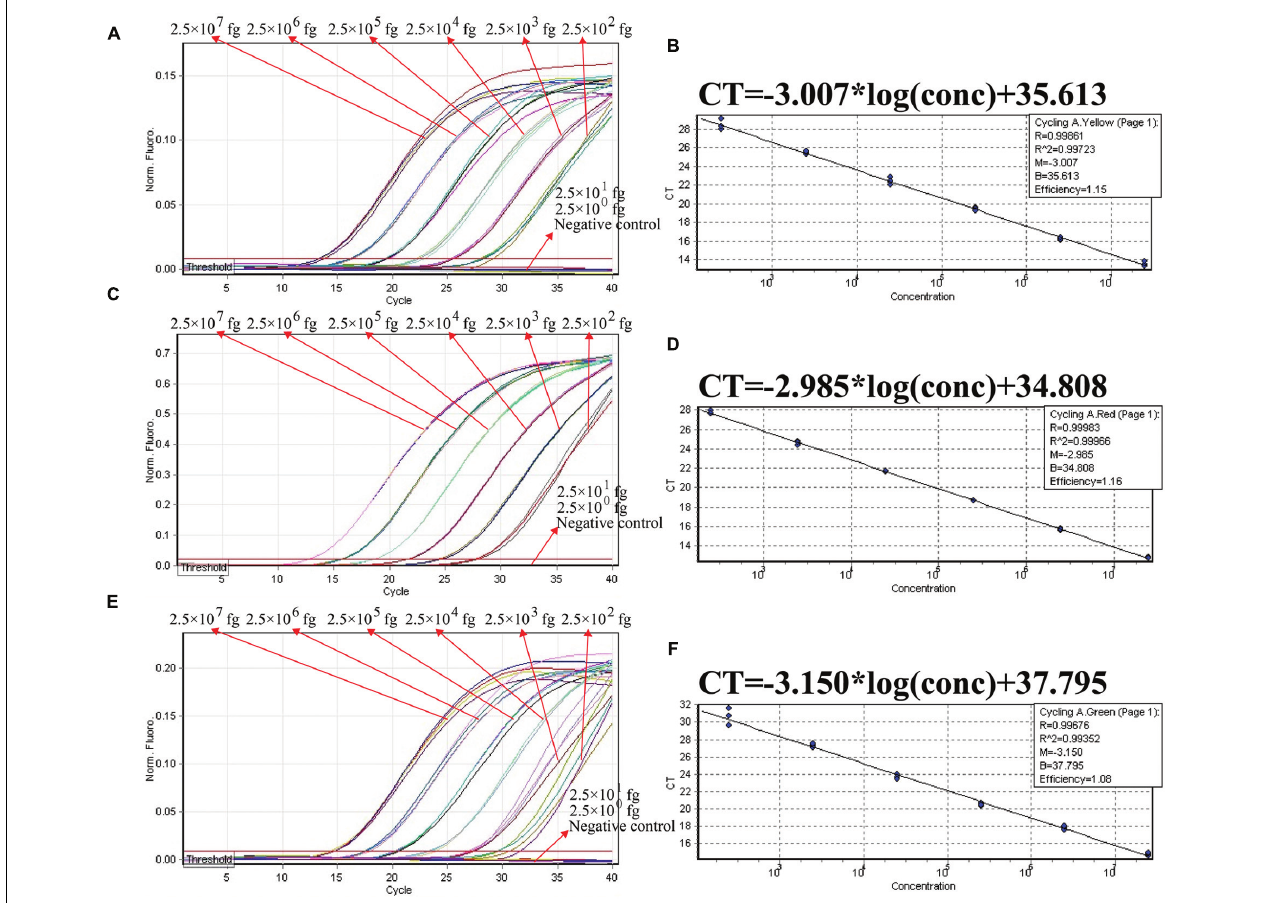
FIGURE 4 | The analytical sensitivity of ET-PCR assay for detecting a single target. Three sets of ET-PCR primer targeting ply , nuc, and Ef0027 genes were in different reactions: S. pneumoniae (A) , S. aureus (C) , and E. faecalis (E) . The DNA levels from 2.5 × 10 7 to 2.5 × 10 2 fg per tube provide the positive signals, 2.5 × 10 1 and 2.5 × 10 0 fg per reaction and negative control generate negative signal. ( B; S. pneumoniae ), ( D ; S. aureus ), and ( F ; E. faecalis ), C t was plotted against the sample DNA concentration (fg) of the